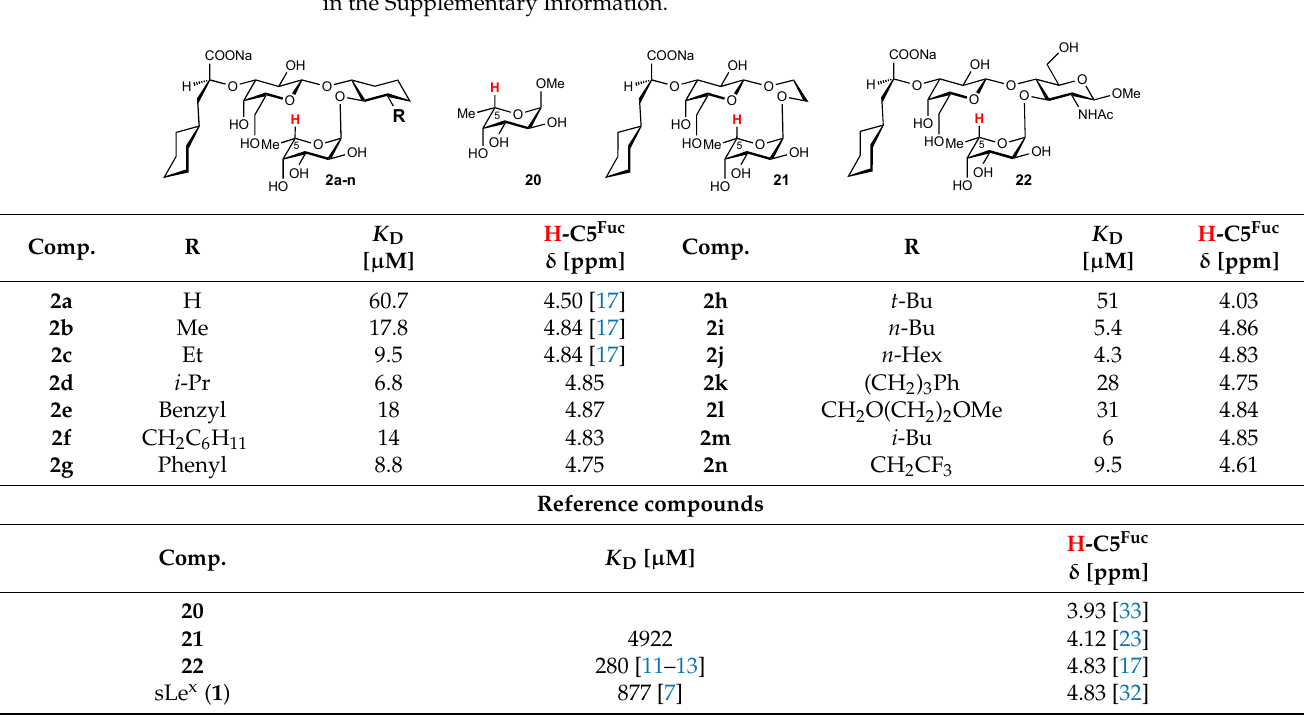
Table 2. The affinity of the E-selectin antagonists 2a-n was assessed by microscale thermophoresis (MST) measurements. Chemical shifts from 1 H NMR experiments. Affinities and 1 H NMR chemical shift for 1 , 2a , 20–22 are literature data [7,17,32,33,35]. Synthesis and assay procedures are described in the Supplementary Information.